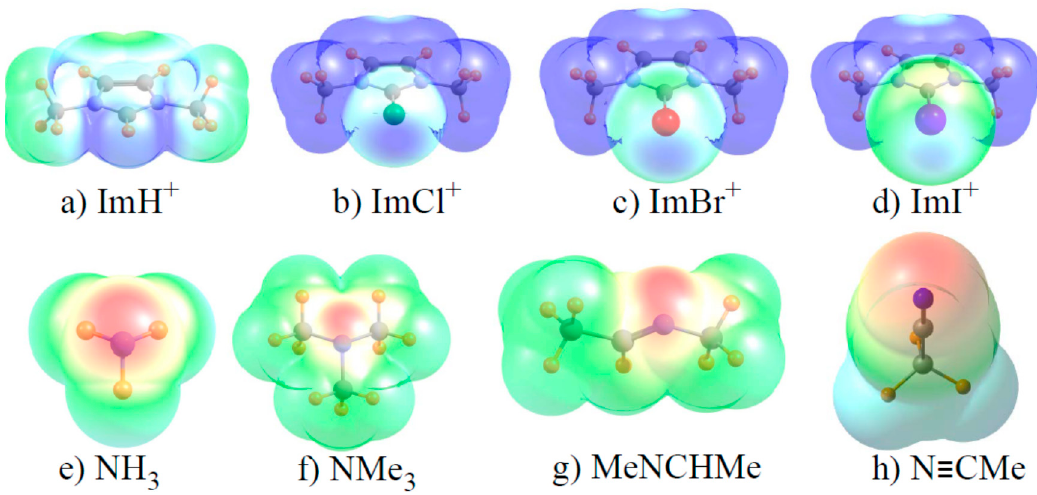
Figure 3. Molecular electrostatic potential surrounding each monomer on an isodensity surface of ρ = 0.001 au. Minimum (red) and maximum (blue) regions correspond respectively to ( a ) 0.15–0.20; ( b – d ) 0.10–0.15; ( e – h ) − 0.08–+0.08. All potentials drawn on surface corresponding to 1.5 times the van der Waals radius of each atom.